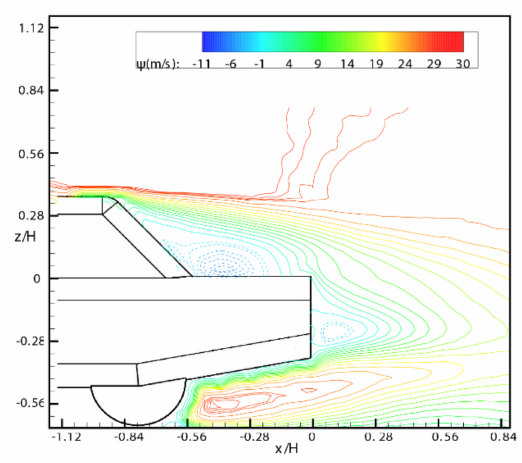
Figure 19. Iso-contours of t time-averaged streamwise velocity in x–z plane at y/H =